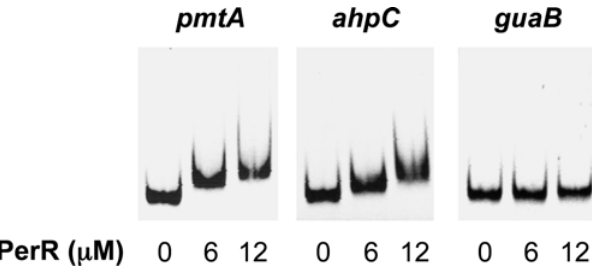
Figure 8. PerR binds to pmtA ( spyM3_1093 or SPy1434 ) and ahpC ( spyM3_1770 or SPy2079 ) promoters (242 bp and 219 bp, respectively) encompassing canonical Per boxes. Each of the two promoter fragments, or the negative control guaB promoter (246 bp), was incubated with recombinant his 6 -PerR at the concentrations indicated for 15 min at room temperature. Following analysis on native polyacrylamide gels, electrophoretic mobility shift of each promoter fragment was visualized by ethidium bromide staining.